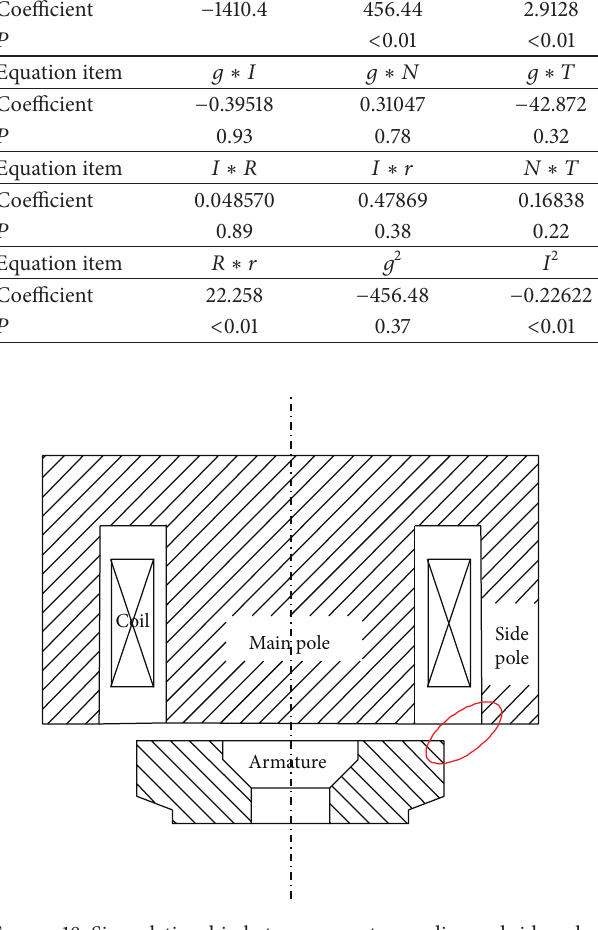
Figure 18: Size relationship between armature radius and side pole radius.